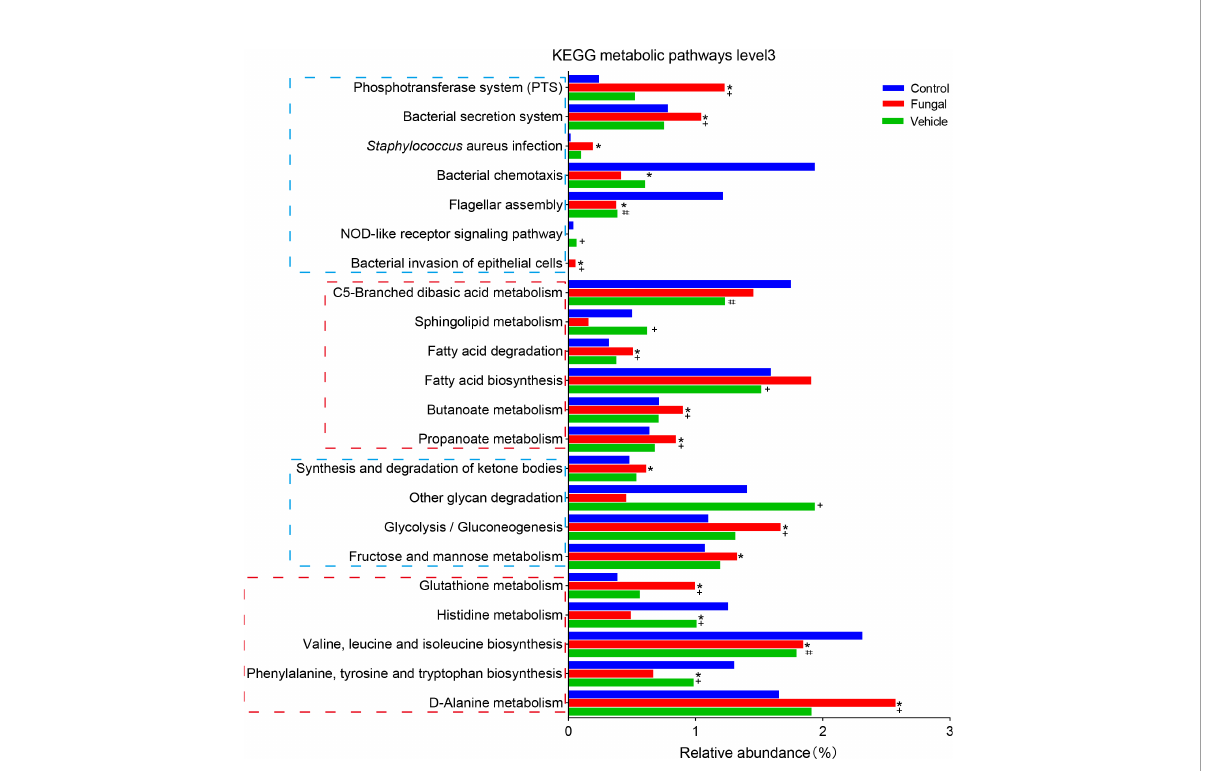
FIGURE 5 Differences in intestinal KEGG metabolic pathways level 3 among control rats, rats infected with fungi after antibiotic treatment and rats inoculated with fungi only. *P < 0.05 vs Control, #P < 0.05 vs Control, +P < 0.05 vs Fungal. The P value was calculated with a Kruskal – Wallis